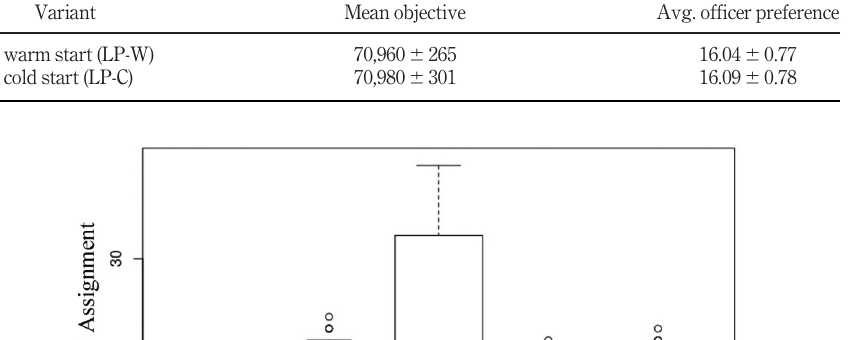
Table 5. Solution quality LP